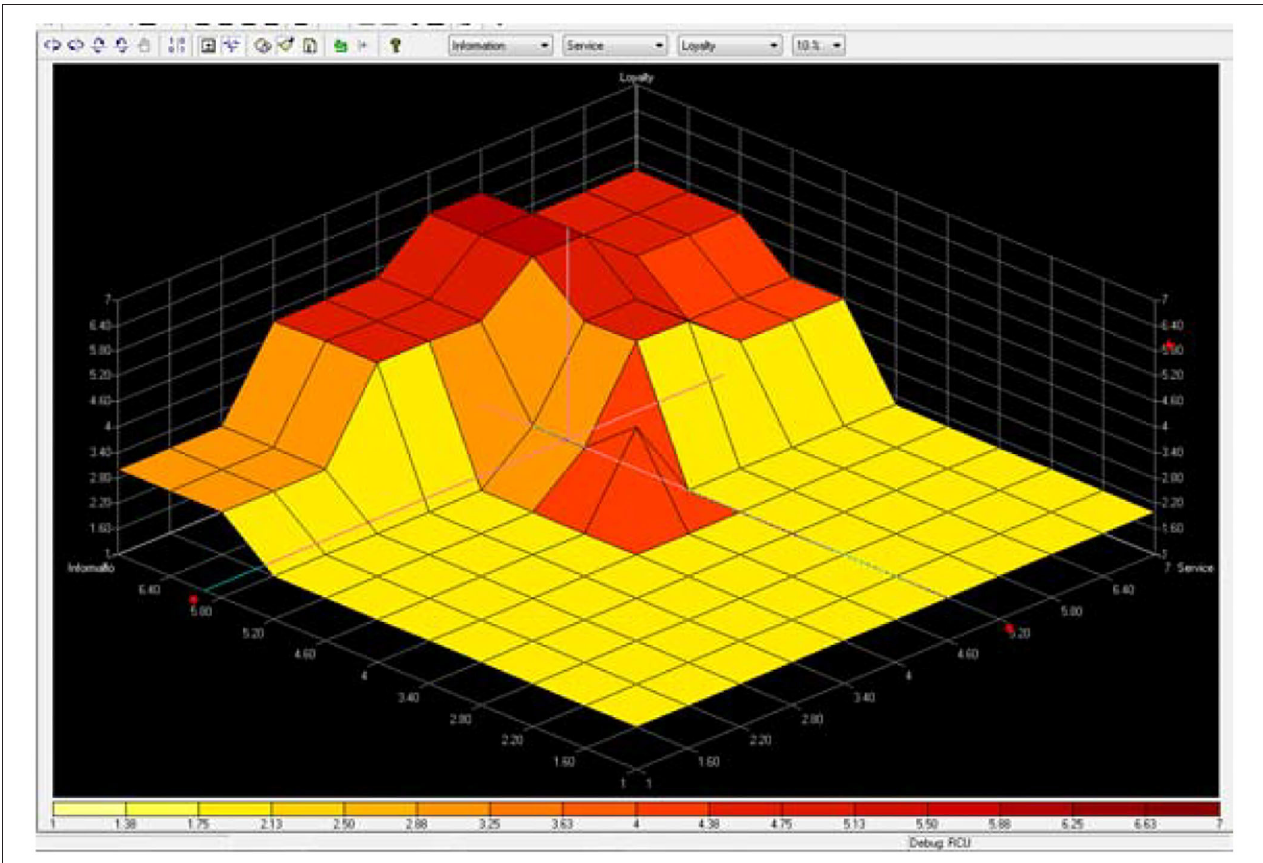
FIGURE 6 | Loyalty is positively to information and